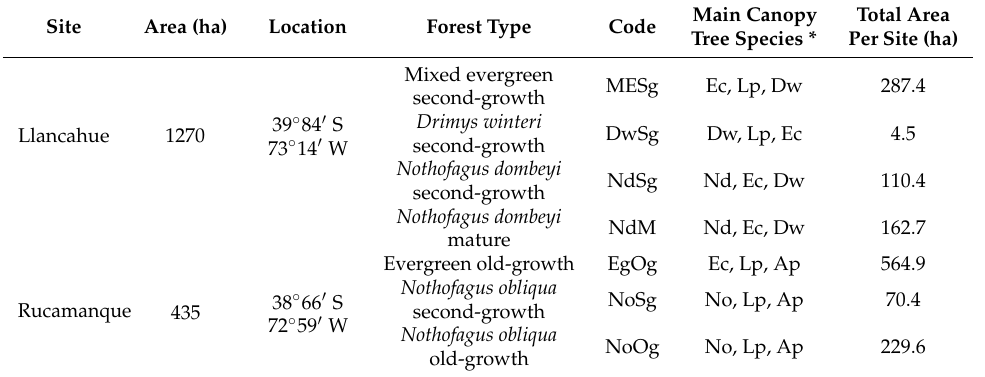
Table 1. General description of Llancahue and Rucamanque and of the seven forests studied in them.